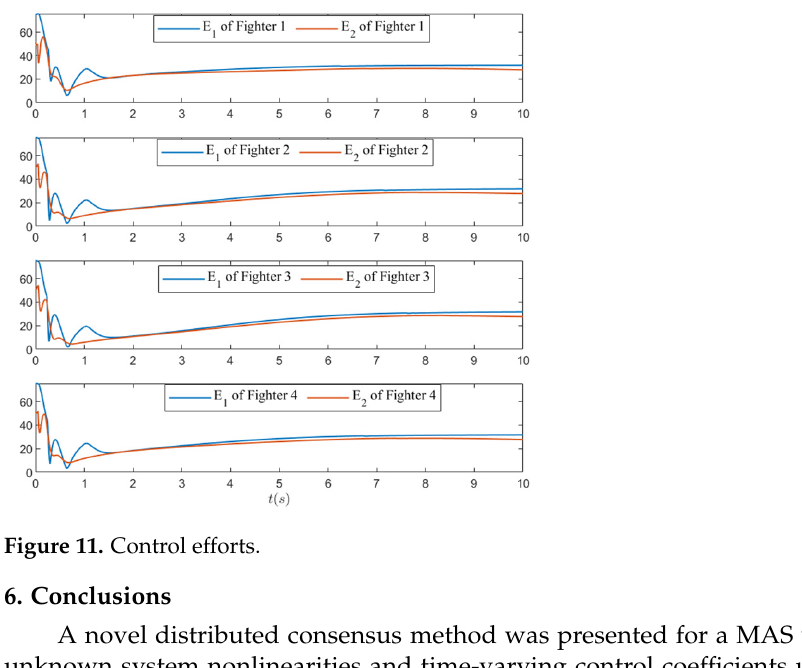
Figure 10. Actuator actions of Fighter 4.